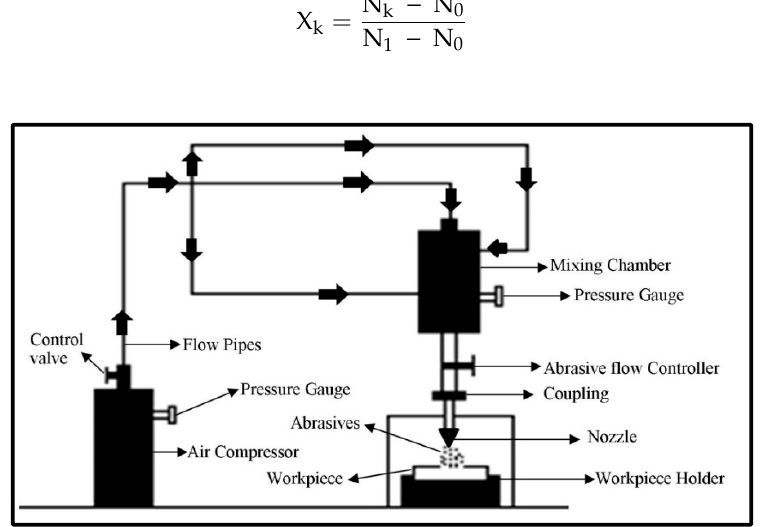
Figure 1. Schematic of the developed solid erosion test setup.